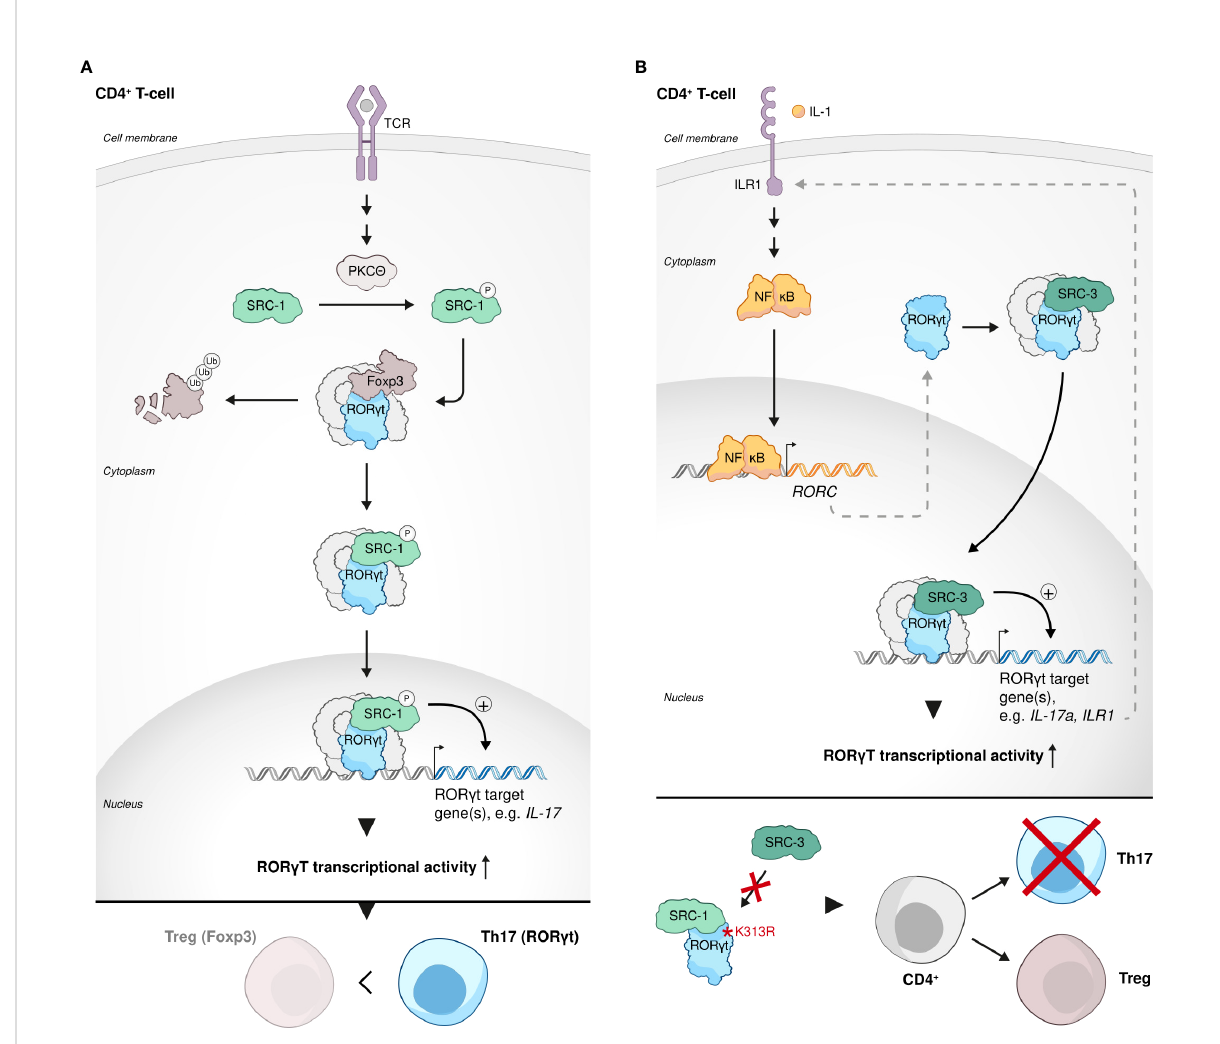
FIGURE 3 SRCs in Th17 cell development and function. (A) SRC-1-ROR g t complex stimulates phenotypic dominance of the Th17 cell lineage over the Treg cell lineage. Following phosphorylation by protein Kinase C q (PKC q ), SRC-1 replaces FOXP3 in its complex with ROR g t in CD4+ cells, subjecting FOXP3 to proteasomal degradation and stimulating Th17 cell lineage phenotypic dominance. (B) SRC-3 is an essential regulator of Th17 cell genes. SRC-3 regulates pathogenic in fl ammation via coactivation of ROR g t-associated expression of Th17 cell genes through an IL-1-ILR1 mediated signaling axis (top). Interaction of ROR g t with SRC-3 is important for healthy Th17 cell lineage development: a K313R mutation of ROR g t speci fi cally disrupts the ability of ROR g t to interact with SRC-3 but not SRC-1 and impairs healthy differentiation and development of Th17 cells